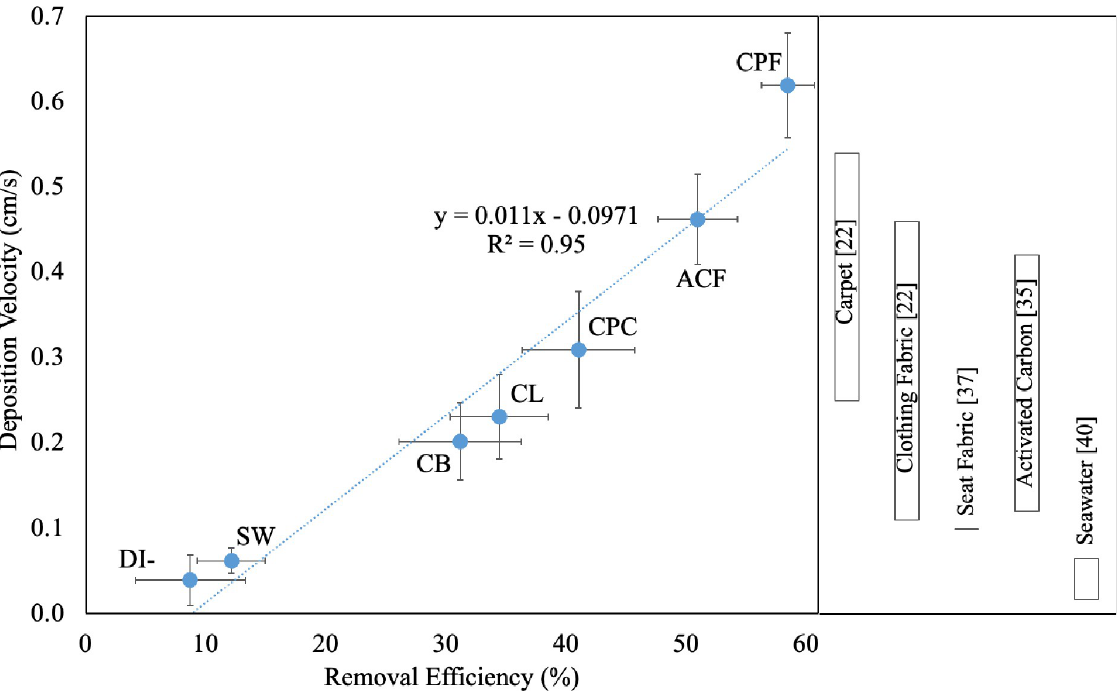
Fig 5. The deposition velocity versus the removal efficiency for the materials under test. The bars on the right are the deposition velocity ranges for the materials reported in the literature. https://doi.org/10.1371/journal.pone.0273188.g005 effective reacting surface area of the coarse coffee powder (thus the level of oxidation) is smaller than that of the fine coffee powder. On the other side, the OC ratio of the activated car- bon powder increases significantly by +73.7% after reacting with ozone because of the large surface area and the release of the organics (the sign of oxidation) [43]. The XPS analysis was conducted (Thermo Scientific, Theta Probe) to analyze the surface functional groups and the binding energy for the coffee powder. Fig 6 shows the survey spec- trum of the coarse coffee powder and there are two clear peaks for C1s and O1s at 284.6 eV and 531.4 eV, respectively, close to the data reported [44]. Fig 7 and Table 4 show the C1s core levels for both the fine and the coarse coffee powder that were conducted before and after reacting with ozone. It demonstrates that there are three oxidation-related functional groups,